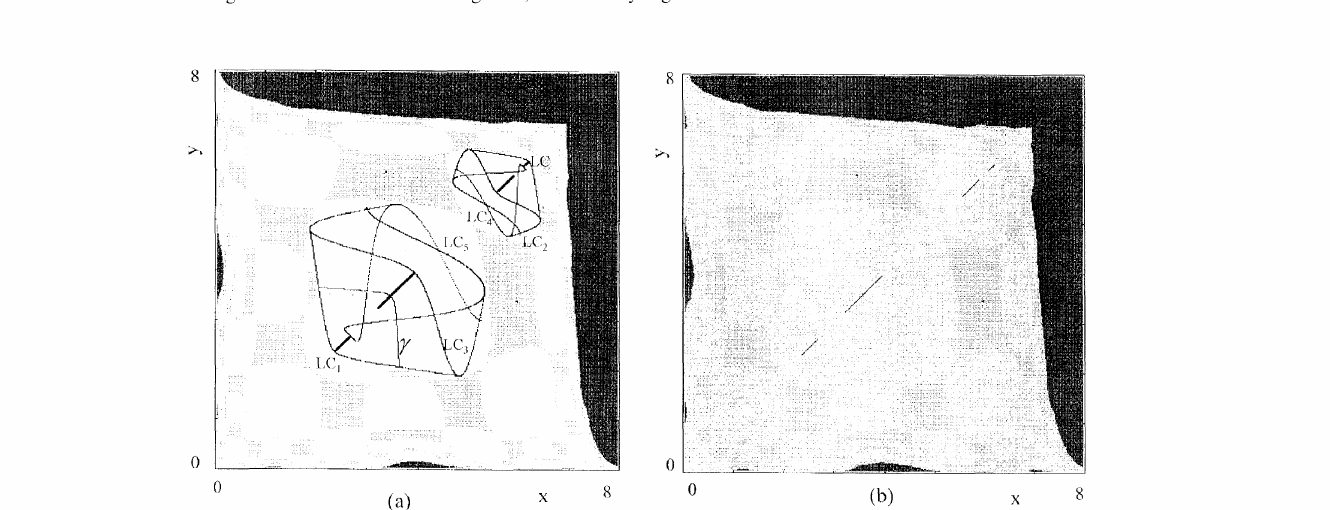
FIGURE 4 (a) With the same parameters A;, B and k as in Figure 2, and 1 ]2 =0.09, the 4-cyclic chaotic set A,,,, which is a Milnor attractor with A’ > 0 and A nat.. 0.15 < 0, coexists with an attracting cycle C2 of period 2, with periodic points out of A. The points of the white region generate trajectories which synchronize on A.,,, whereas points in the light-grey region converge to C2. The boundaries of the minimal absorbing area including A.,, are also shown. (b) For/:]1 [32 =0.1 the basin of A,,, is riddled with the basin of